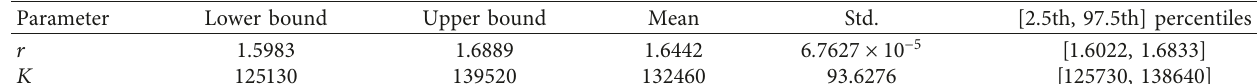
Figure 6: Parameter histograms of logistic model of the IABC-SMC algorithm. (a) Estimation of r . (b) Estimation of K . Here, the initial � 22 , a � 0 . 4 , T � 6 , and t � 12. states are n � 6000 ,x 0 Table 7: Parameter ranges and statistics of logistic model.